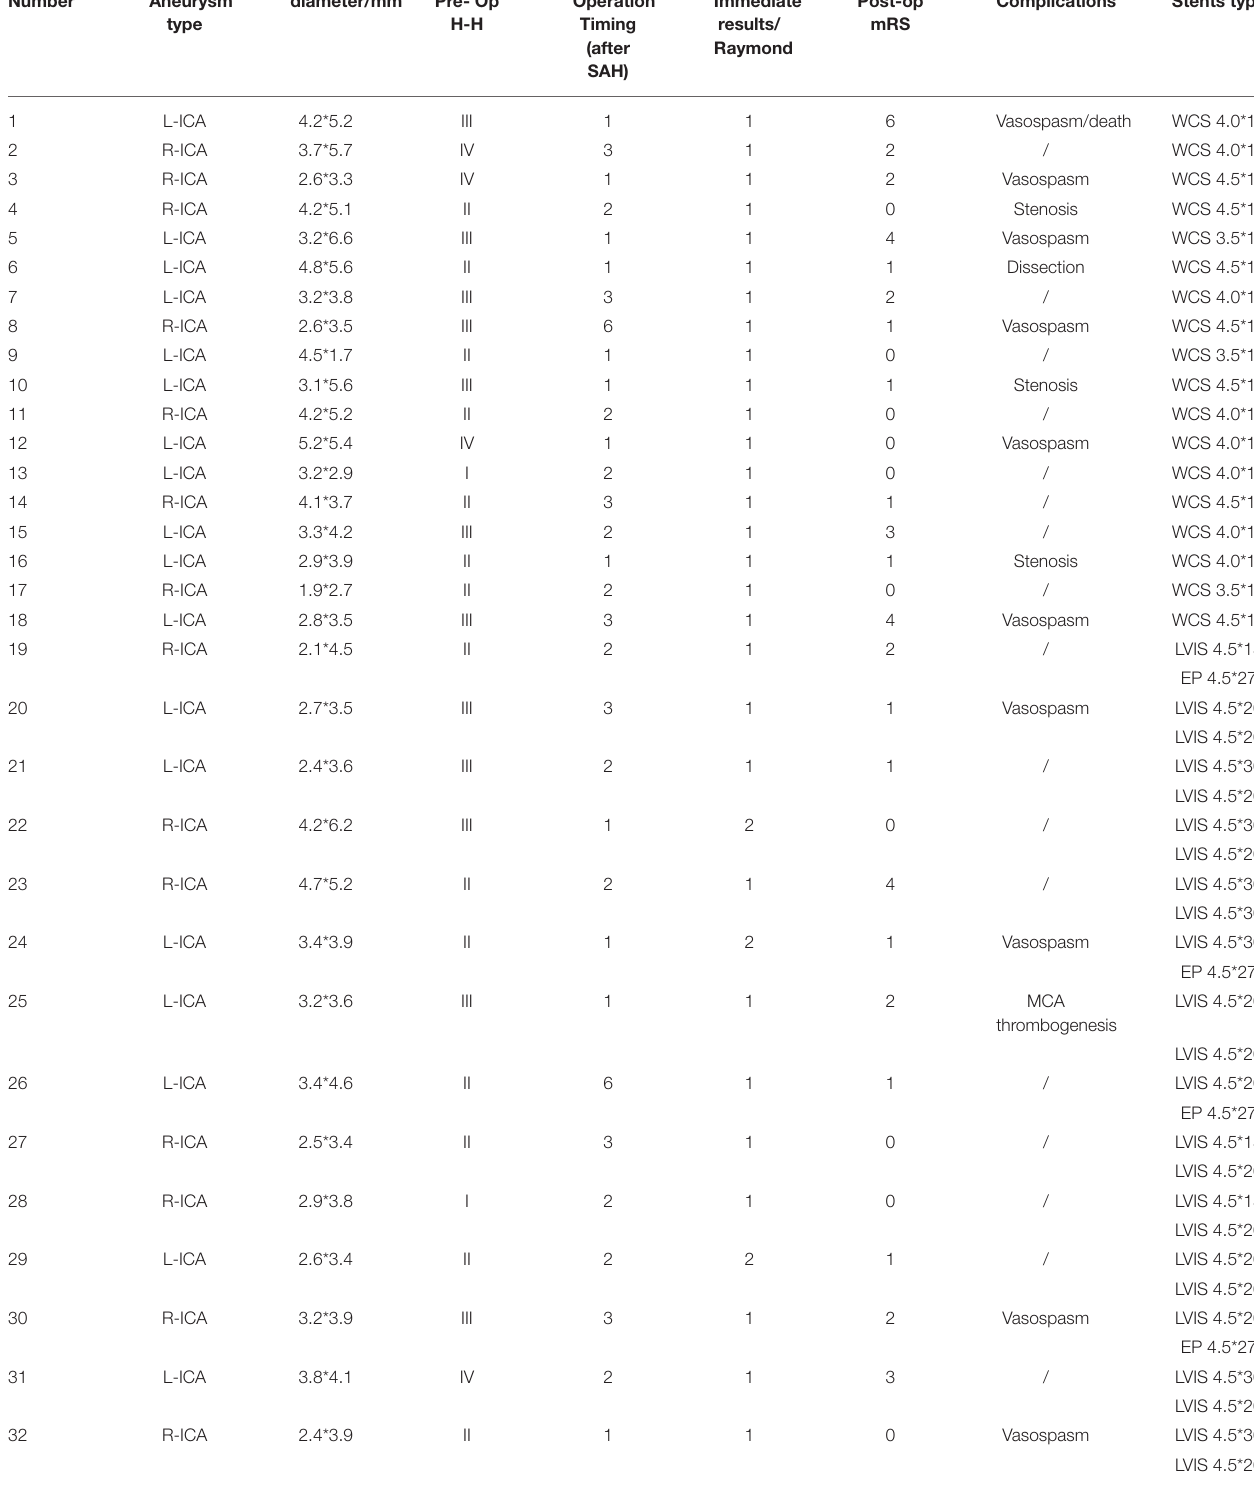
TABLE 1 | Endovascular treatment, outcome, and follow-up data for 32 patients with blister-like aneurysms (BBAs).